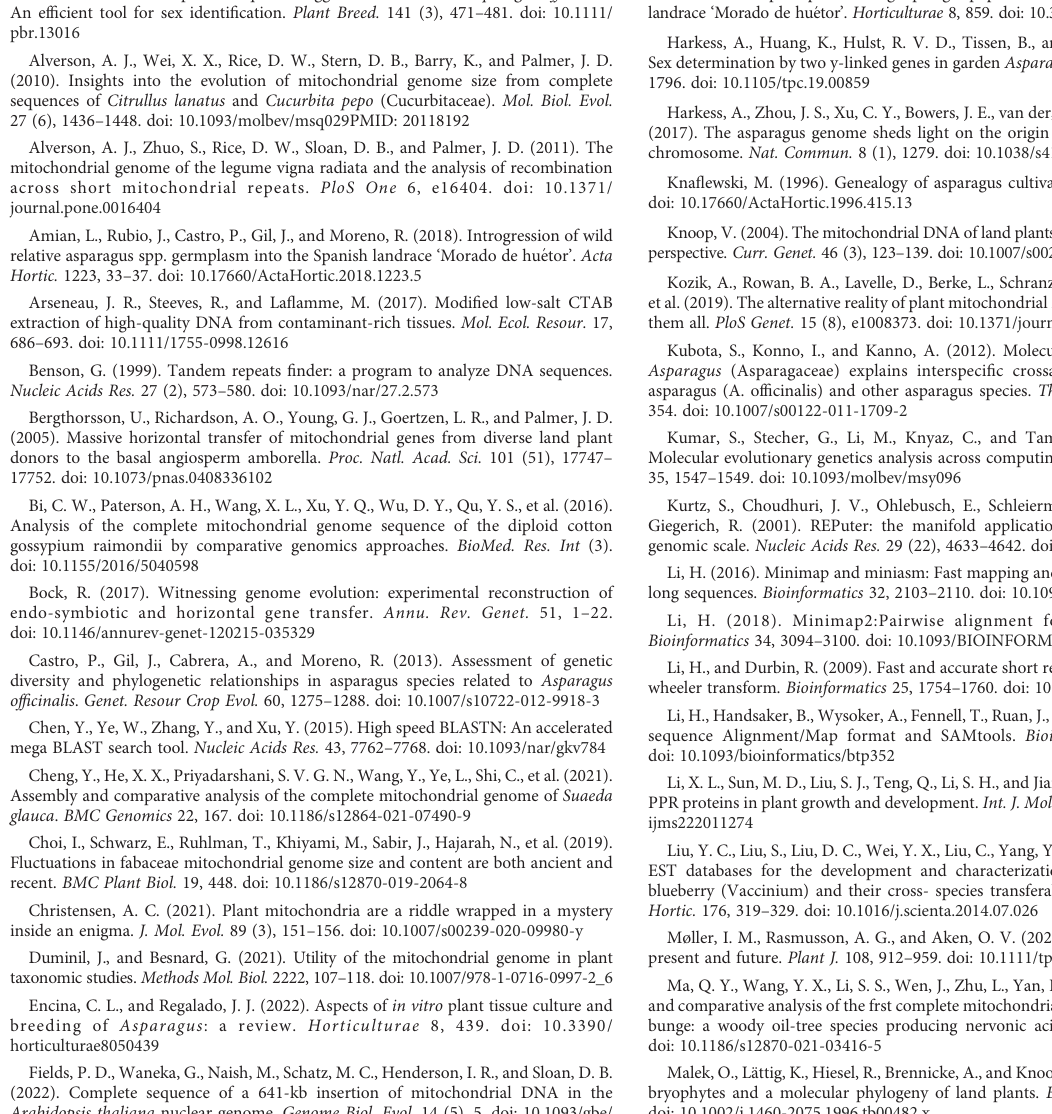
SUPPLEMENTARY TABLE 1 Plant species used in phylogenetic studies. SUPPLEMENTARY TABLE 2 Fragments transferred from chloroplast to mitochondrial genome in garden asparagus. SUPPLEMENTARY TABLE 3 Organization of mitochondrial genomes in garden asparagus and other six